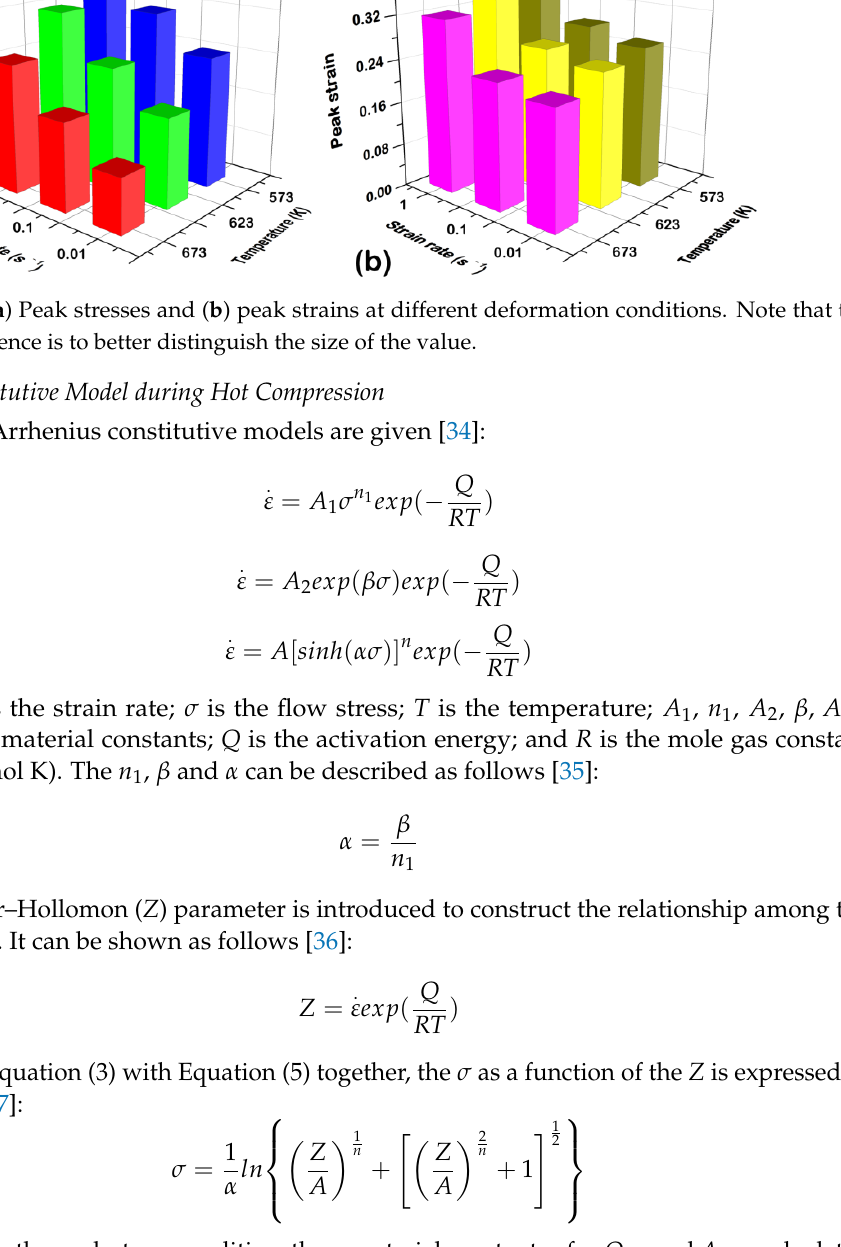
Figure 5a,b show the linear relationships of ln slopes of these two functions are considered the average n 1 and β values (~7.317 and ~0.089, respectively). According to Equation (4), the α is estimated by